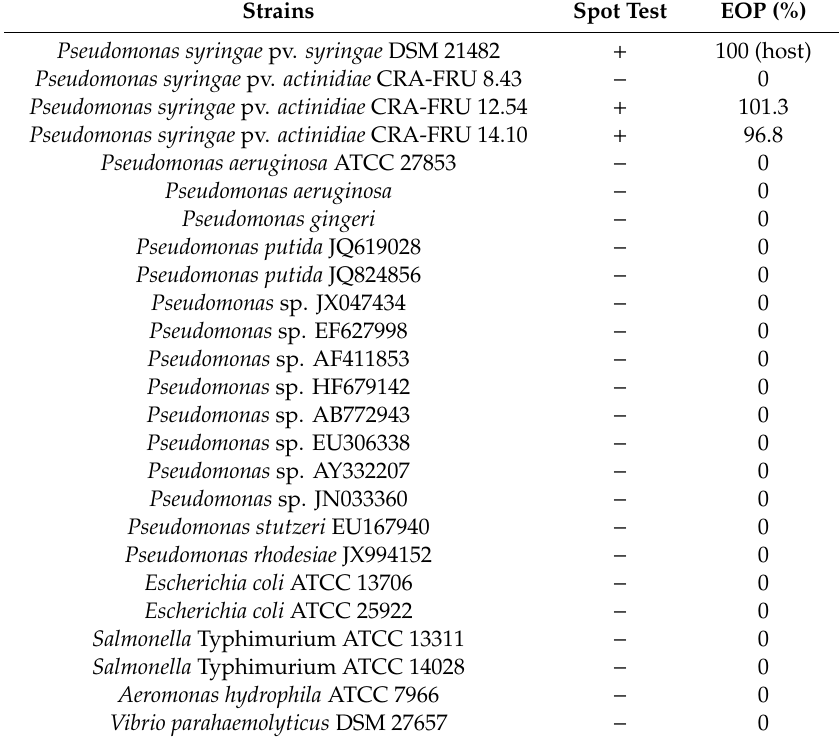
Table 1. Host range of phage φ 6 determined on 25 bacterial strains. Clear lysis zone ( + ) and not lysis zone ( − ). The plating with the host strain was considered as EOP = 100%. EOP: E ffi ciency of Plating. Strains Spot Test EOP (%) Pseudomonas syringae pv. syringae DSM 21482 + 100 (host) Pseudomonas syringae pv. actinidiae CRA-FRU 8.43 − 0 Pseudomonas syringae pv. actinidiae CRA-FRU 12.54 + 101.3 Pseudomonas syringae pv. actinidiae CRA-FRU 14.10 + 96.8 Pseudomonas aeruginosa ATCC 27853 − 0 Pseudomonas aeruginosa − 0 Pseudomonas gingeri − 0 Pseudomonas putida JQ619028 − 0 Pseudomonas putida JQ824856 − 0 Pseudomonas sp. JX047434 Pseudomonas sp. EF627998 − 0 Pseudomonas sp. AF411853 − 0 Pseudomonas sp. HF679142 − 0 Pseudomonas sp. AB772943 − 0 Pseudomonas sp. EU306338 Pseudomonas sp. AY332207 Pseudomonas sp. JN033360 Pseudomonas stutzeri EU167940 Pseudomonas rhodesiae